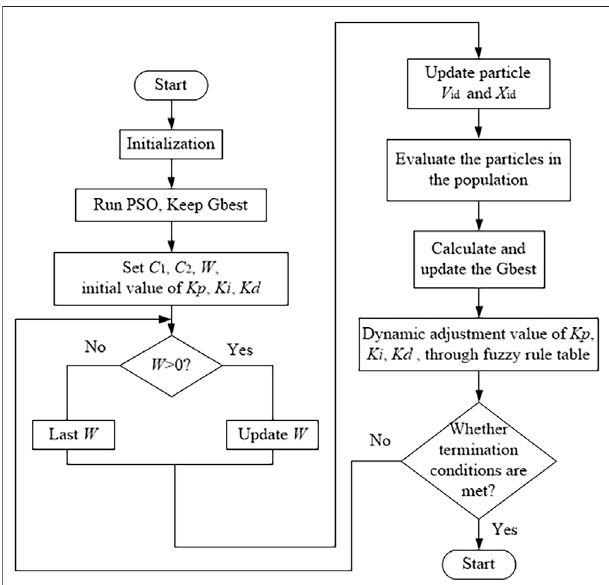
FIGURE 7 | Fuzzy PID algorithm fl ow based on